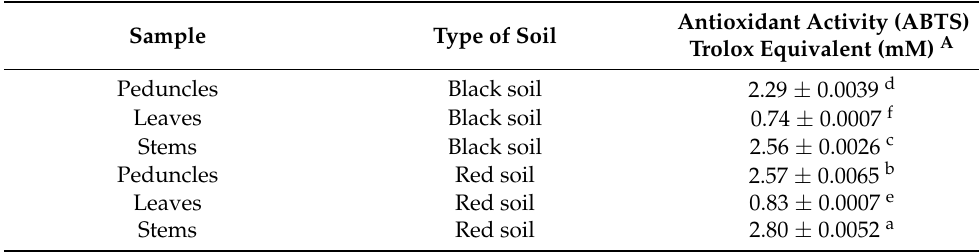
Table 1. Antioxidant activity of methanolic extracts of habanero pepper by-products of plants grown on black and red soils obtained by